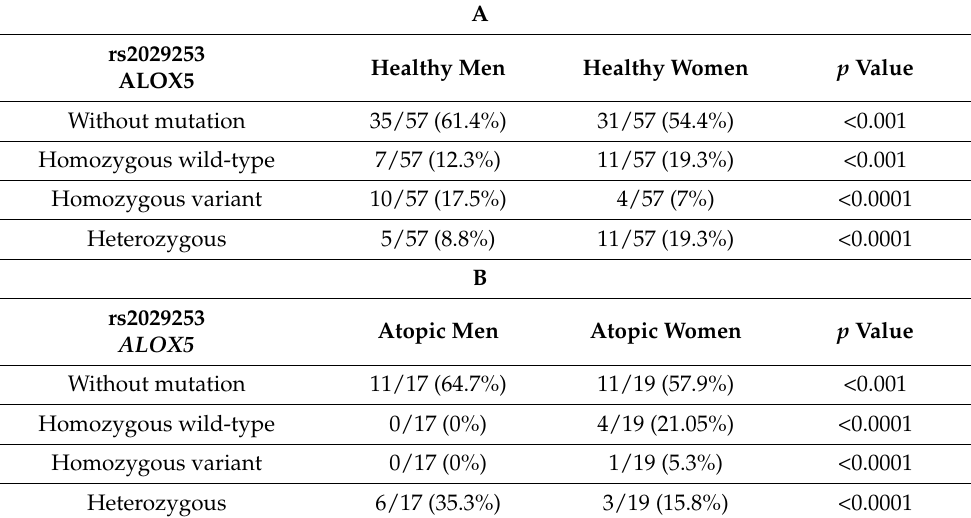
Table 4. Genotype and allele frequency in Healthy ( A ) and Atopic ( B ) M and W, based on the ALOX5 rs2029253 polymorphism. The statistical tests used in these analyses were the one-way analysis of variance followed by the Tukey Multiple Comparison